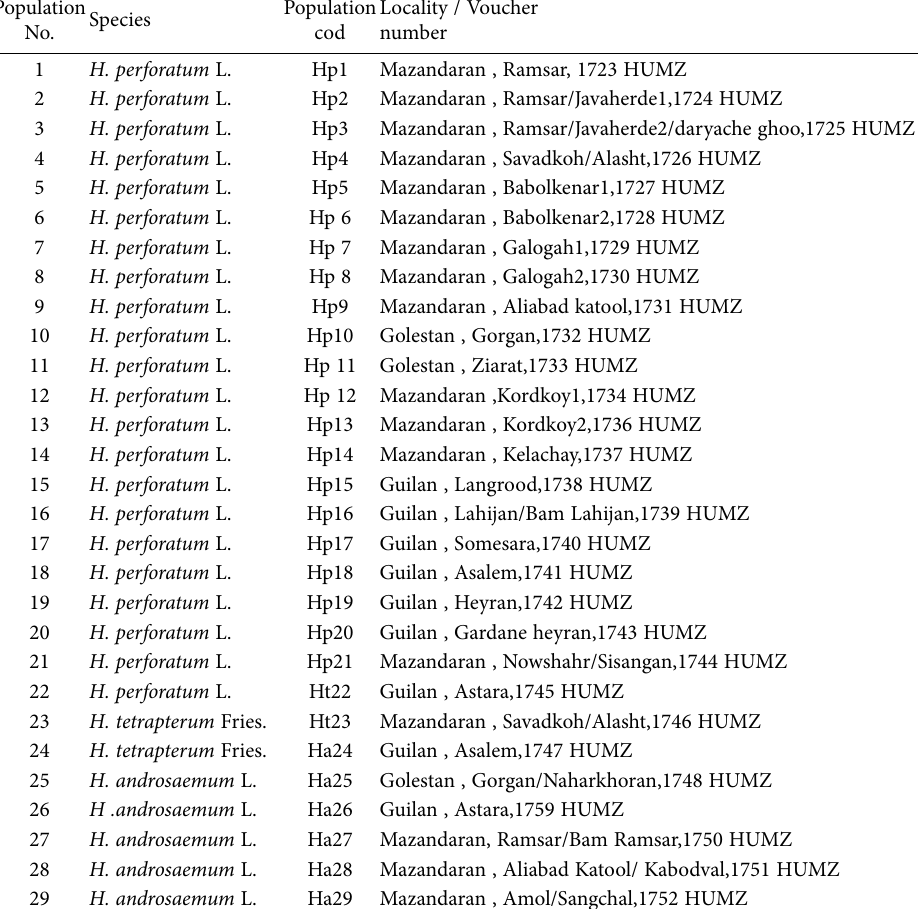
Table 1. Voucher details of Hypericum species examined in this study from Iran. Population